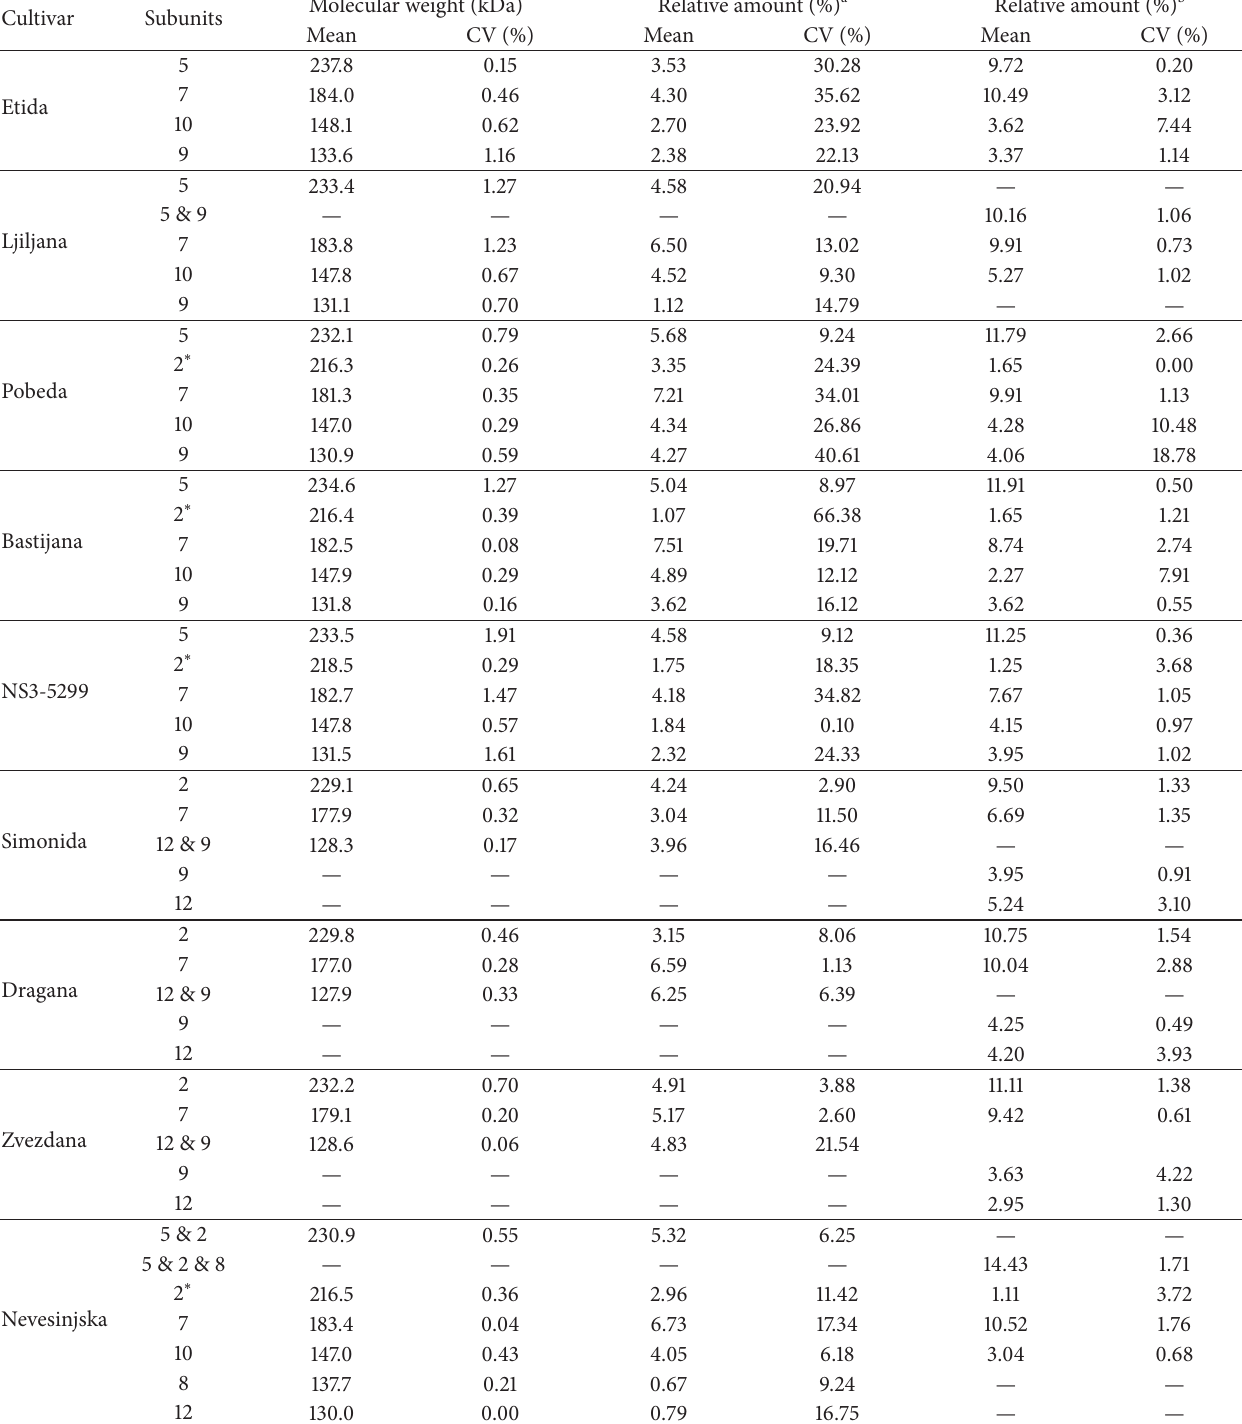
Table 3: Apparent sizes and quantification of individual HMW-GS subunits of nine bread wheat cultivars grown in Serbia by LoaC method and quantification of individual HMW-GS subunits by